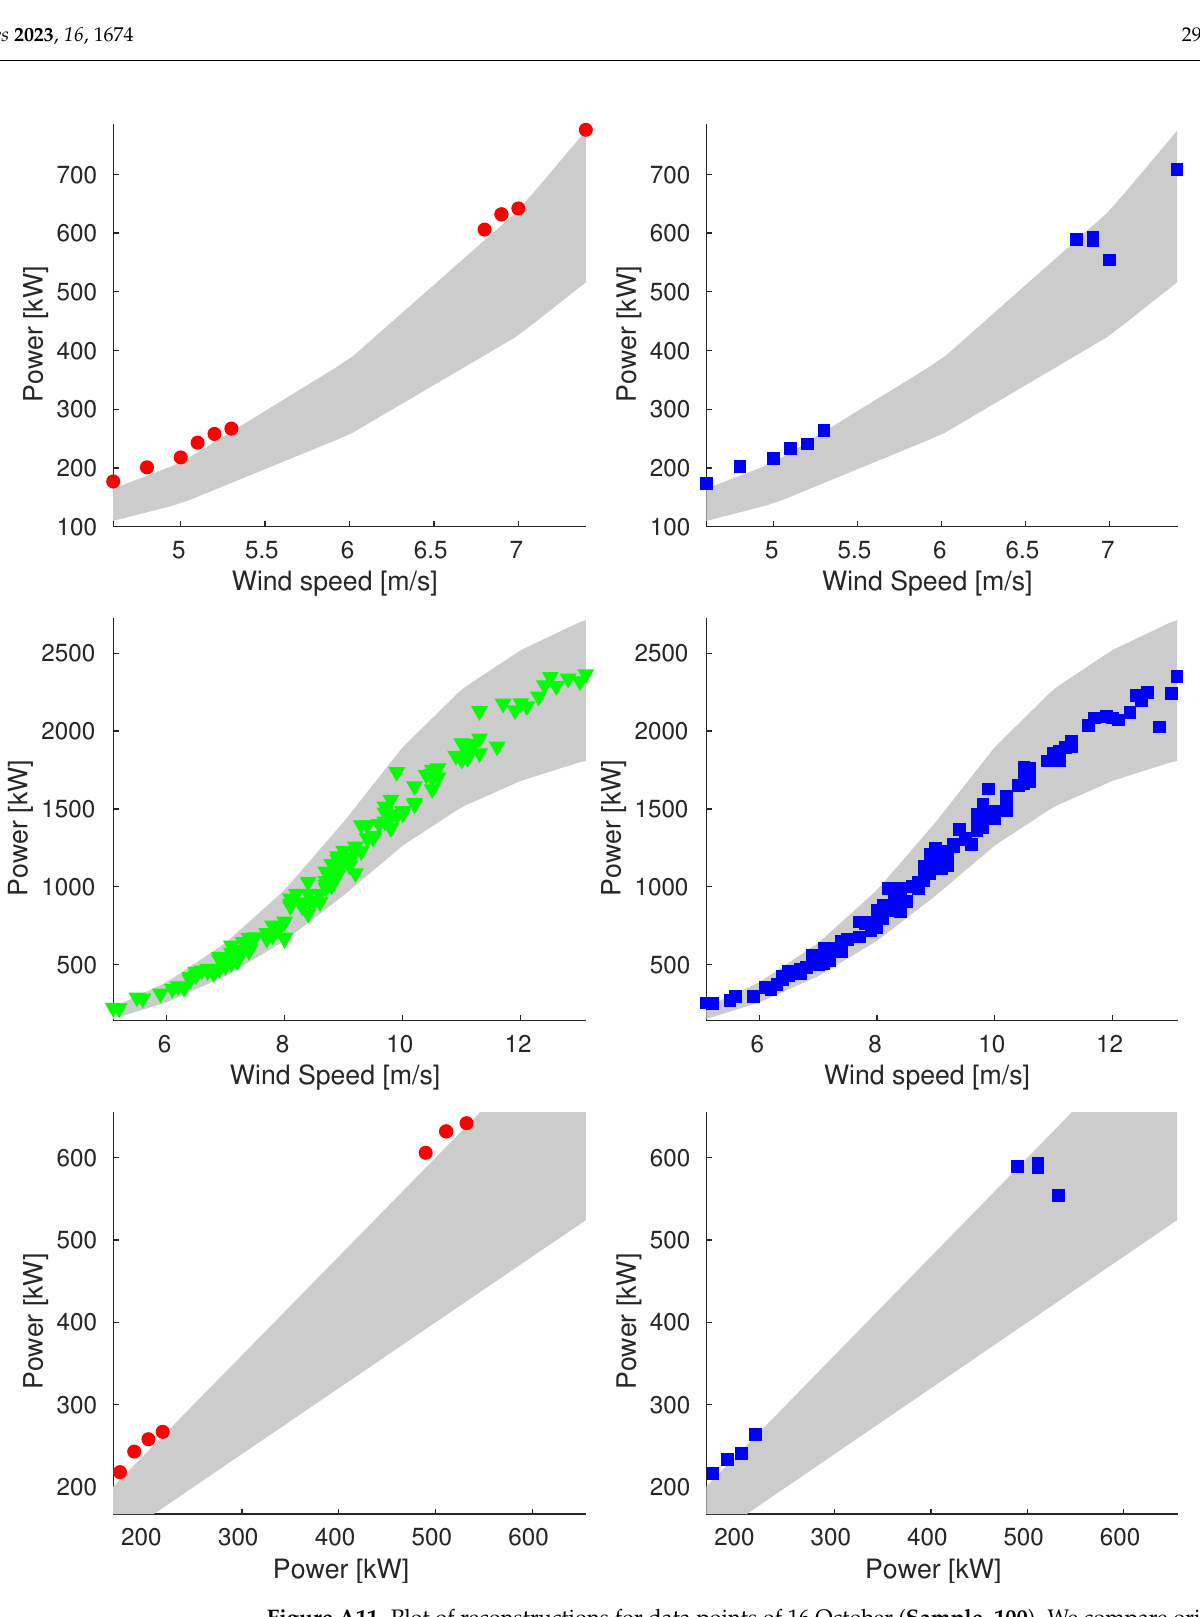
Figure A11. Plot of reconstructions for data points of 16 October ( Sample_100 ). We compare original data (on the left ) and reconstructed values (on the right ). We show plots of power vs.wind speed of rejected and validation data ( up and middle respectively) and plot of power vs.ideal power of rejected data ( bottom